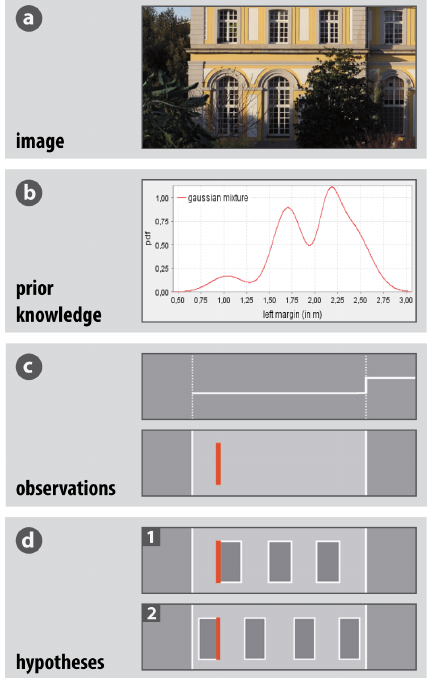
Figure 1: predicting substructures in building facades: a) facade image of Poppelsdorf Castle, b) distribution (Gaussian mixture) as prior knowledge, c) footprint and measurements of embrasures as observations, d) resulting hypotheses for a row of windows This paper illustrates the approach with the prediction of a row of windows in a building facade. Figure 1 depicts the prediction for a facade of the Poppelsdorf Castle in Bonn, Germany. Prior knowledge is incorporated as probability density functions and constraints on the model parameters. The facade width f is, for example, correlated with the number n of windows, the width w of the windows, the distance d between these windows and